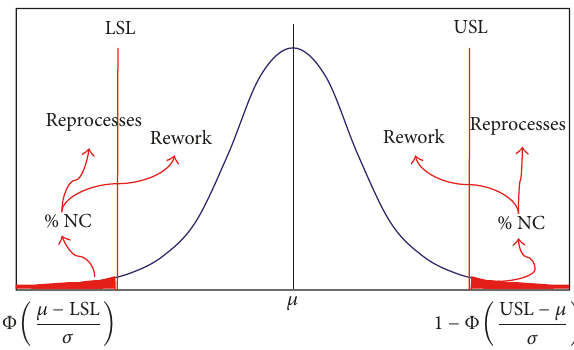
Figure 2: Percentage of nonconforming product for reprocessing and rework.